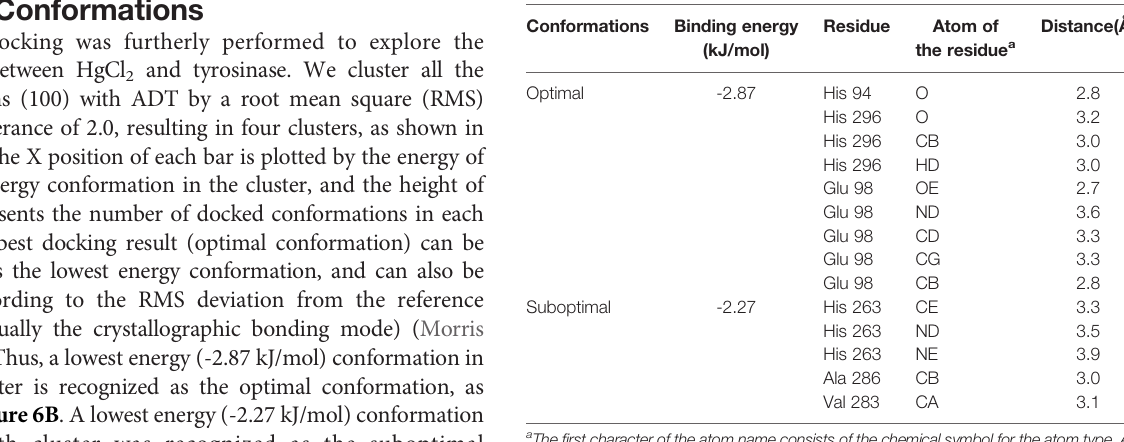
TABLE 1 | Information between the amino acid residues and HgCl 2